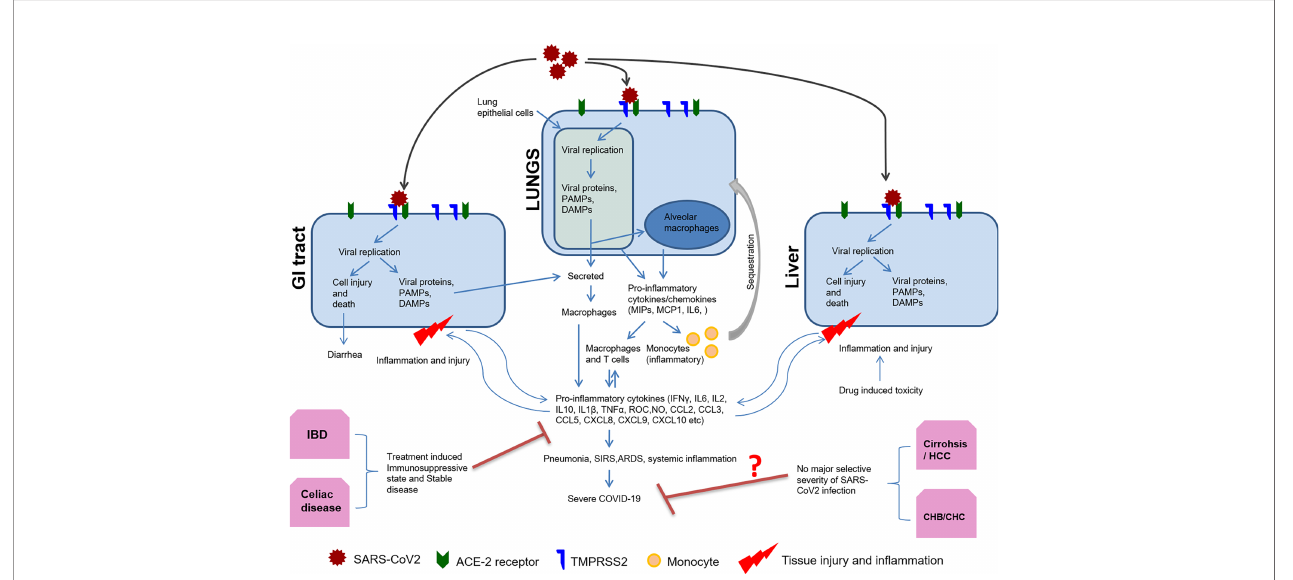
FIGURE 1 | Host immune response to SARS-CoV2 and organ-speci fi c immunomodulation. Organ speci fi c expression of viral entry receptor ACE2 and host protease TMPRSS2 determine SARS-CoV2 tropism and replication. Host cell mounts immune response by sensing viral replication and its intermediates through PAMPS or DAMPS. Subsequently, there is antigen presentation, the release of pro-in fl ammatory cytokines/chemokines, and activation of the adaptive immune response. Monocytes are also sequestered to the site of in fl ammation by chemotaxis and differentiate into macrophages forming the pro-in fl ammatory milieu. This results in pneumonia, ARDS, SIRS, and systemic in fl ammation. Pre-existing disease conditions including liver and GI tract may affect COVID-19 outcome as summarized in this fi